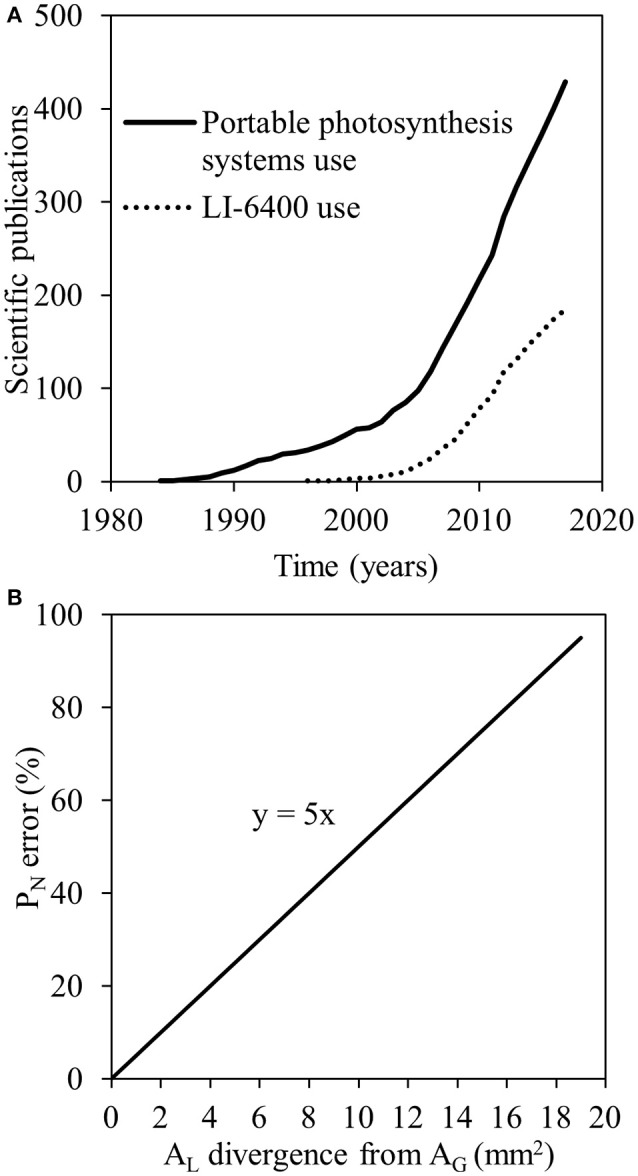
Numbers of scientific publications using portable photosynthesis systems (solid line) and LI-6400 (dashed line) based on searches performed in the Scopus database on January 08, 2018 (A); the error in net photosynthesis (PN) calculation when the actual area of the leaf enclosed in the leaf chamber (measured leaf area; AL) is deviating from internal gasket area (AG) but AL is by default considered equal to AG (20 mm2; B).